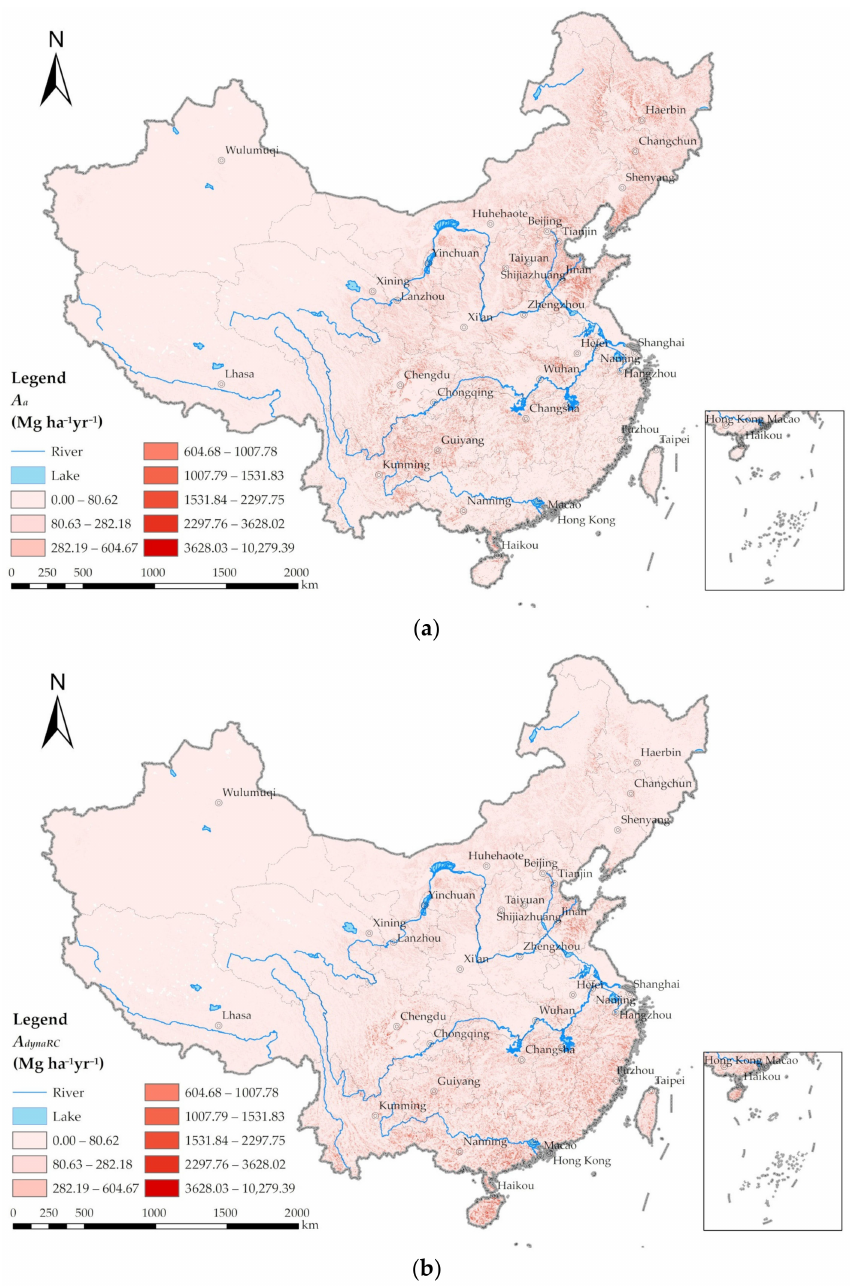
Figure 3. Soil erosion in China (2018). ( a ) Soil erosion calculated using RUSLE, ( b ) Soil erosion calculated using